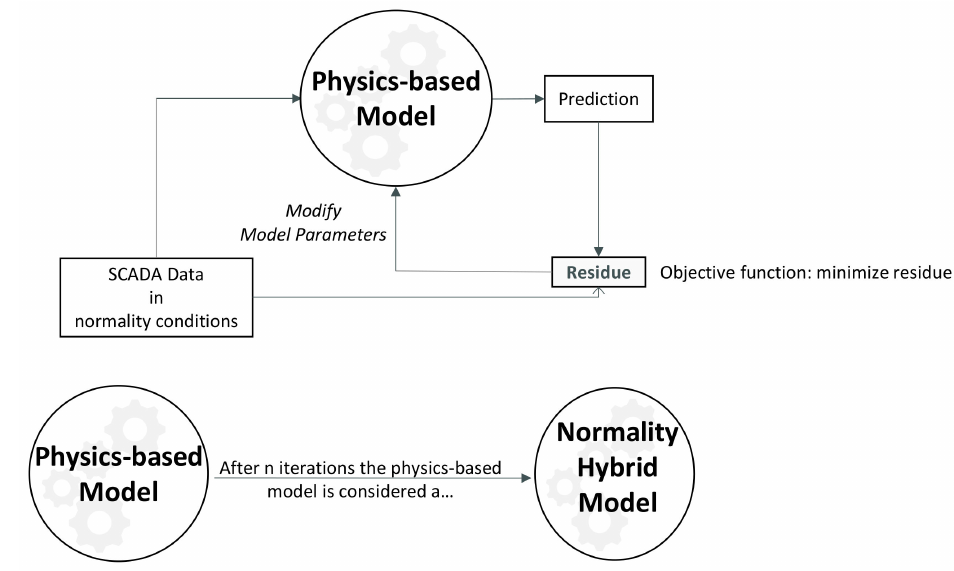
Figure 3. Training of the physics-based model and obtention of the normality hybrid